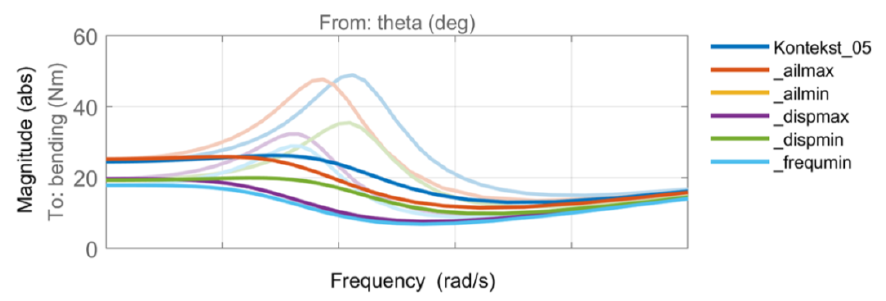
Figure 16. Comparison of open-loop (light) and closed-loop (dark) wing root bending moment.